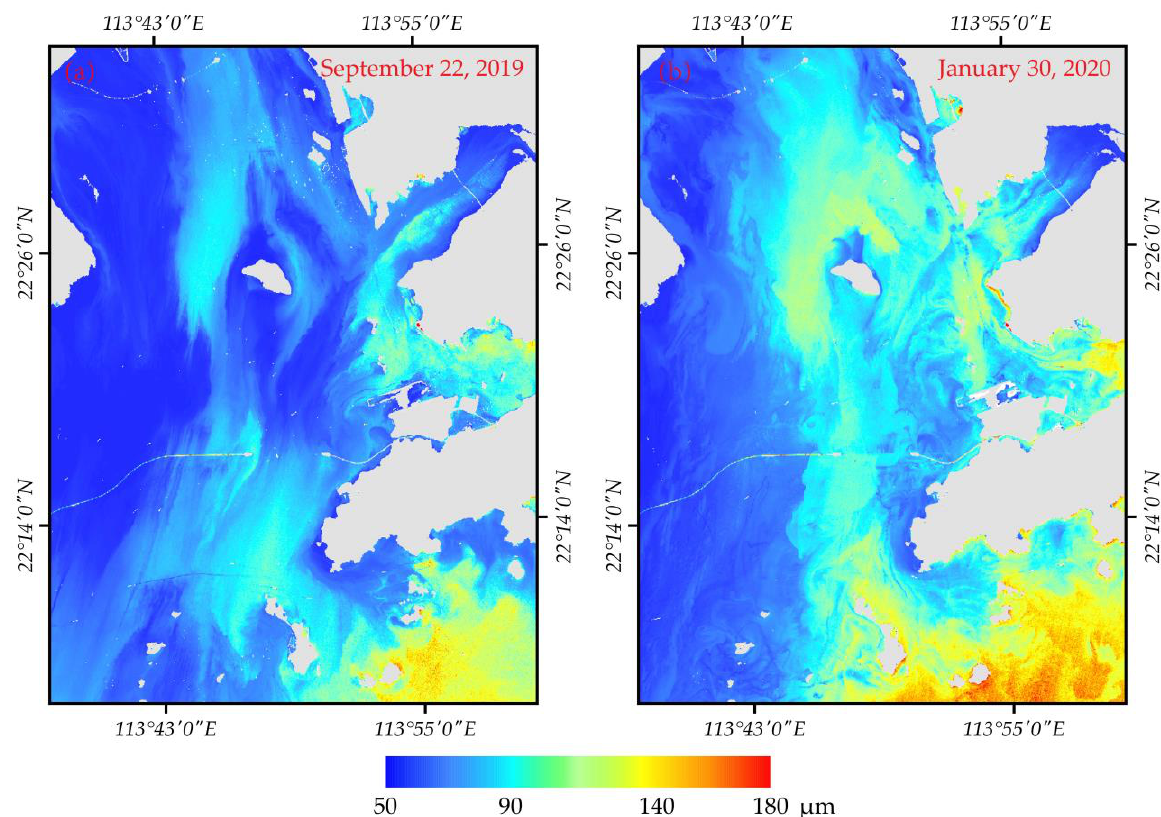
Figure 7. The D v50 distribution retrieved by the proposed method on ( a ) 22 September 2019 and ( b ) 30 January 2020.